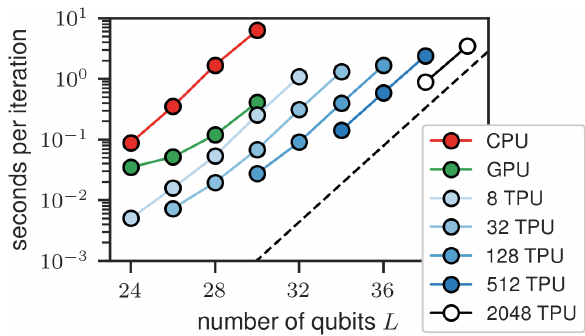
FIG. 6. The wall-clock run time for applying the Floquet uni- tary circuit (two layers of gates) to an L -qubit wave function. The red data at the top left are reference values obtained by simulat- ing the circuit on a standard eight-CPU-core workstation using QSIMCIRQ [88,89]. The green data are QSIMCIRQ simulations run on one NVIDIA A100 GPU. The blue data, from left to right, cor- respond to eight, 32, 128, and 512-TPU-core clusters. The slope of the dashed line indicates the expected asymptotic (large L ) scaling of the computational cost, ∝ L 2 L . The unfilled markers at the top right are extrapolated from the top two points in each series and represent our maximum capacity simulations on 2048 TPU cores. All simulations are performed with single-precision arithmetic. All TPU calculations in this paper are performed on the third generation of TPUs: “TPU